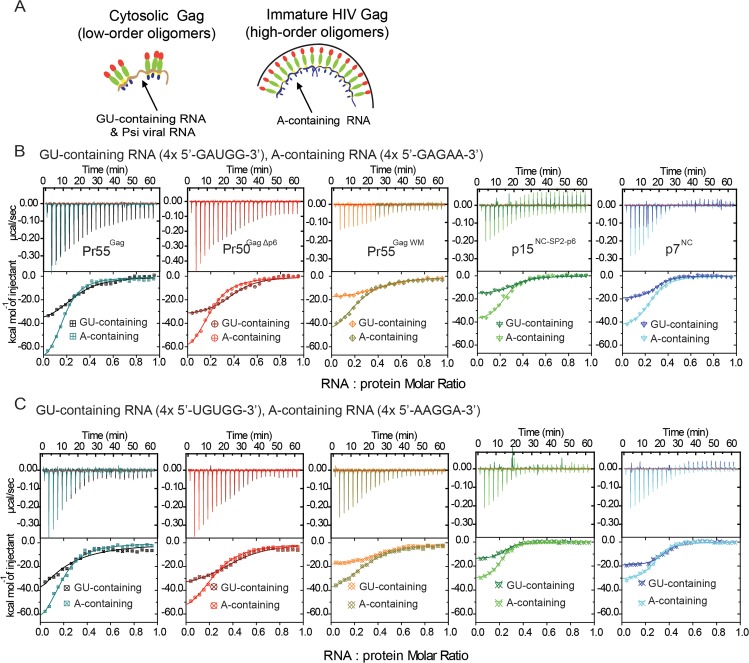
ITC analysis of Pr55Gag-RNA binding show more energetically favourable binding of Pr55Gag to A-containing over GU-containing RNA.(A) Schematic of Pr55Gag-RNA binding specificity during viral assembly. Representative ITC binding curves indicating heat released per mole of oligonucleotide titrated when 40 μM of 20mers; (B) 4x 5’-GAUGG-3’ (GU-containing) and 4x 5’-GAGAA-3’ (A-containing) RNA (n = 3);.and (C) 4x 5’-UGUGG-3’ (GU-containing) and 4x 5’-AAGGA-3’ (A-containing) RNA were injected in 1.5 ul aliquots into 8 μM of Pr55Gag, Pr50GagΔp6, Pr55Gag WM, p15NC-SP2-p6 and p7NC, respectively (n = 2).